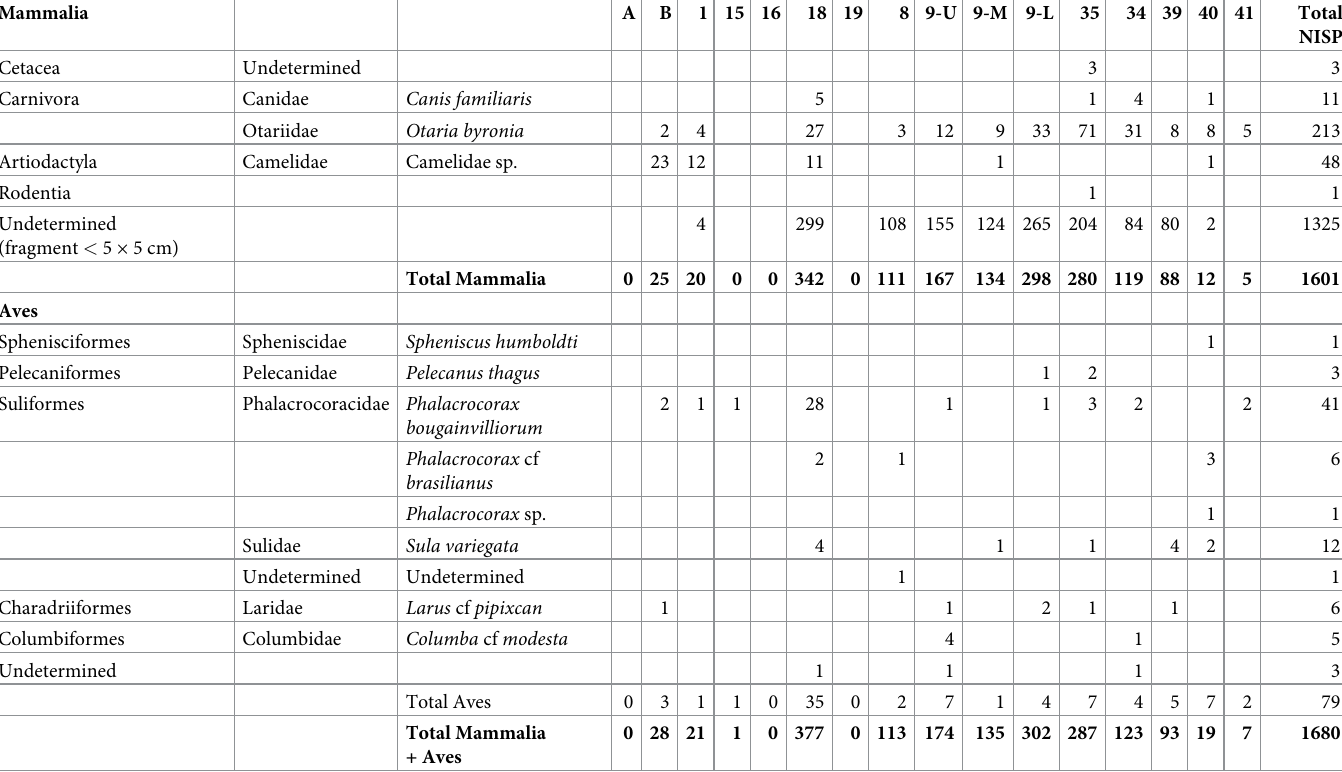
Table 5. Huaca Grande mammalian and avian assemblages: NISP of the taxa identified in trench A4.1. Mammalia A